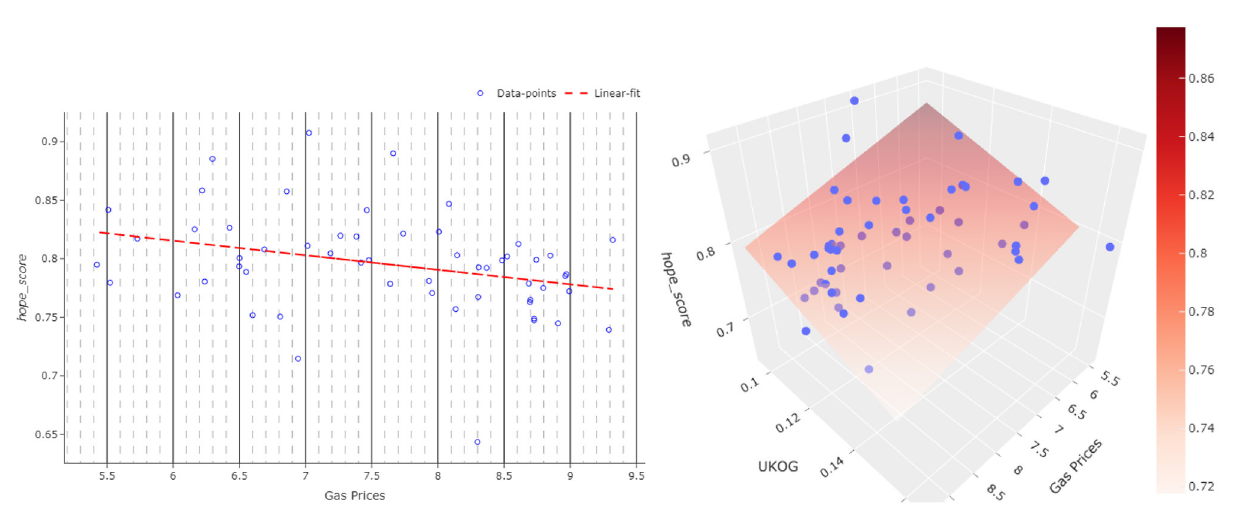
FIGURE6 One- and two-parameter regression analysis plots of the hope score. The sub-plot on (left) is a scatterplot showing the gas price and the hope score regression analysis. The red dashed line refers to the regression line. The sub-plot on (right) shows a 2-parameter regression analysis (UKOG and gas price) in a 3D scatter plot. The surface plotted in this sub-plot shows the 2-regressor model fit